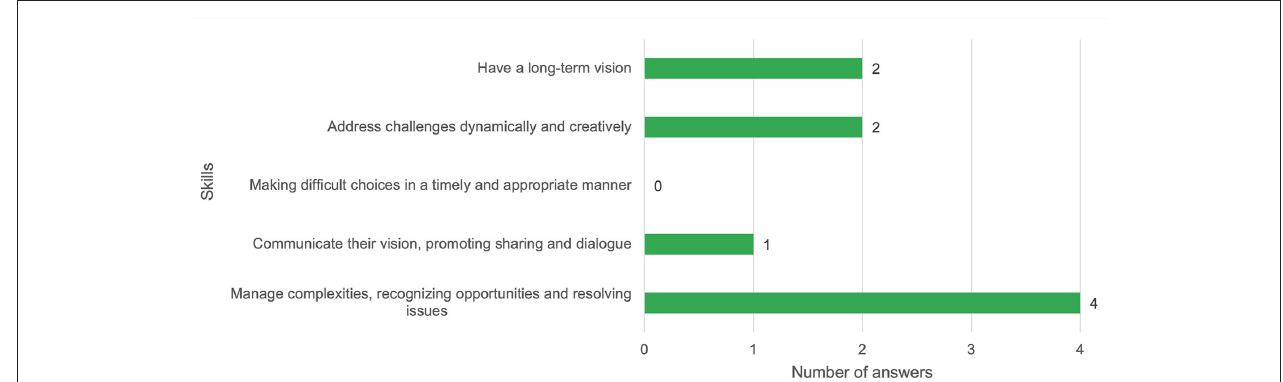
FIGURE 4 | Sustainability leader skills.